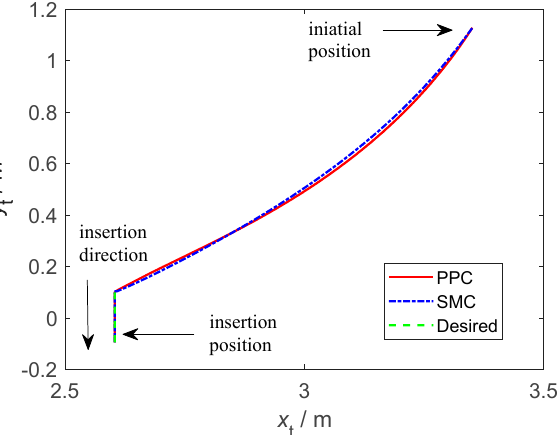
Figure 13. Space robot end X&Y-direction trajectory tracking curve of on-orbit insertion operation with friction change.